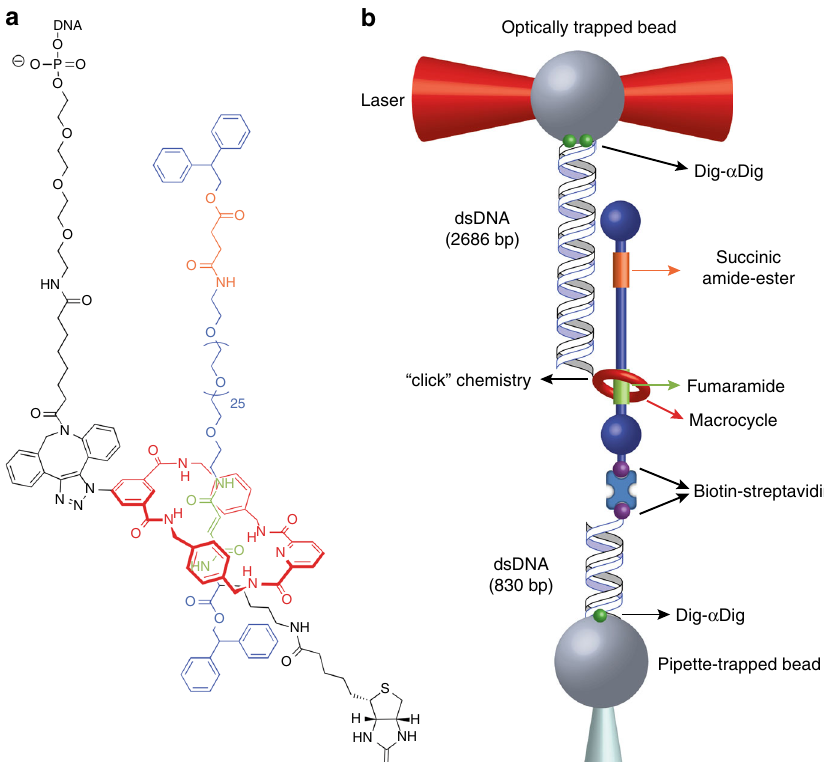
Fig. 1 Molecular design and experimental setup. a The chemical structure of the molecular shuttle consists of a benzylic tetraamide macrocycle (red) locked onto an axle (blue) terminated by diphenylethyl groups at each end (stoppers). The axle contains fumaramide ( fum , green) and succinic amide-ester ( succ , orange) stations separated by a long oligoethyleneglycol spacer. At low forces the macrocycle resides predominantly over the fum station. A DNA oligonucleotide was covalently attached to the macrocycle to allow for manipulation in the optical tweezers. b The molecular shuttle is attached to two polystyrene beads (diameter ~3 μ m) through two dsDNA molecules (not to scale): The 2686 bp dsDNA molecule connects the macrocycle to the bead in the optical trap ( k = 0.13 pN nm − 1 , laser power = 60 mW) via digoxigenin-antidigoxigenin (Dig- α Dig) connections. The 830 bp dsDNA molecule connects the shuttle to a bead held by suction on a micropipette, via biotin-streptavidin connections at one end and Dig- α Dig at the other end. Load is applied to the system by moving the optical trap away from the micropipette. At constant load, the shuttling dynamics of the macrocycle are inferred by measuring